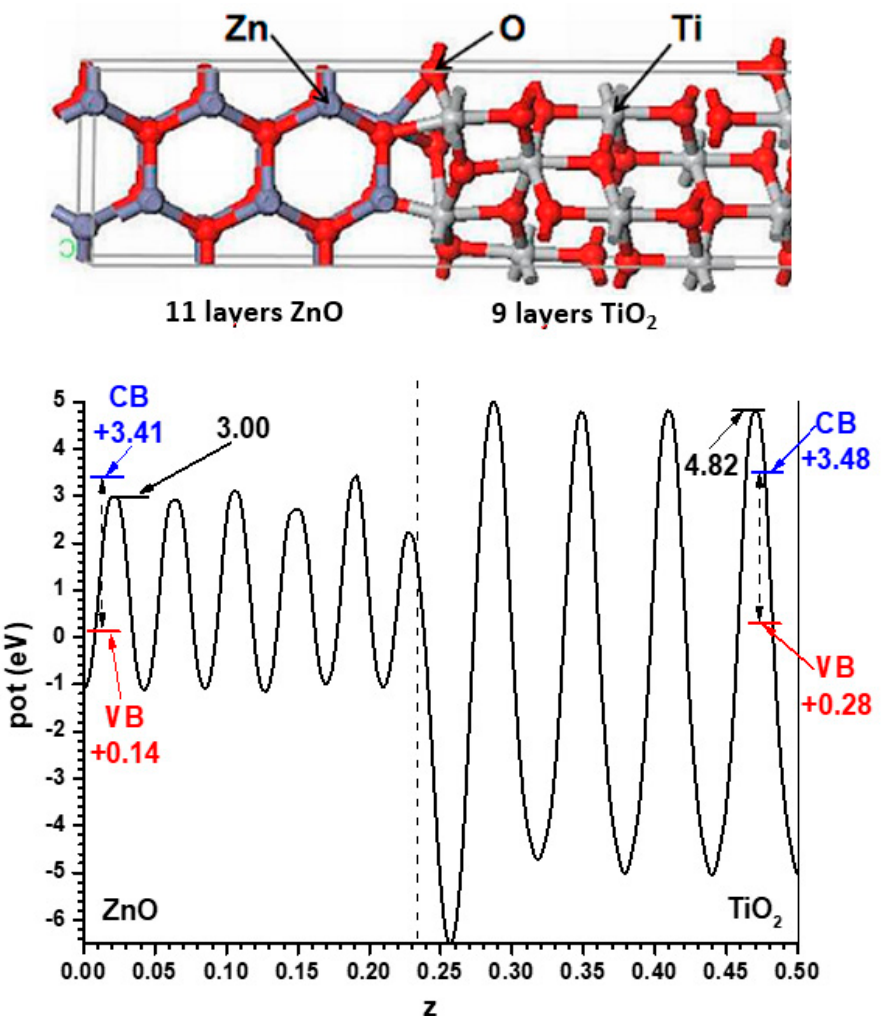
Figure 3. Structure of the fully relaxed mixed ZnO|anatase TiO 2 slab (only half of the unit cell is displayed) together with the Hartree potential profile and the positions of the VB and CB transferred from the results of Figure 1.